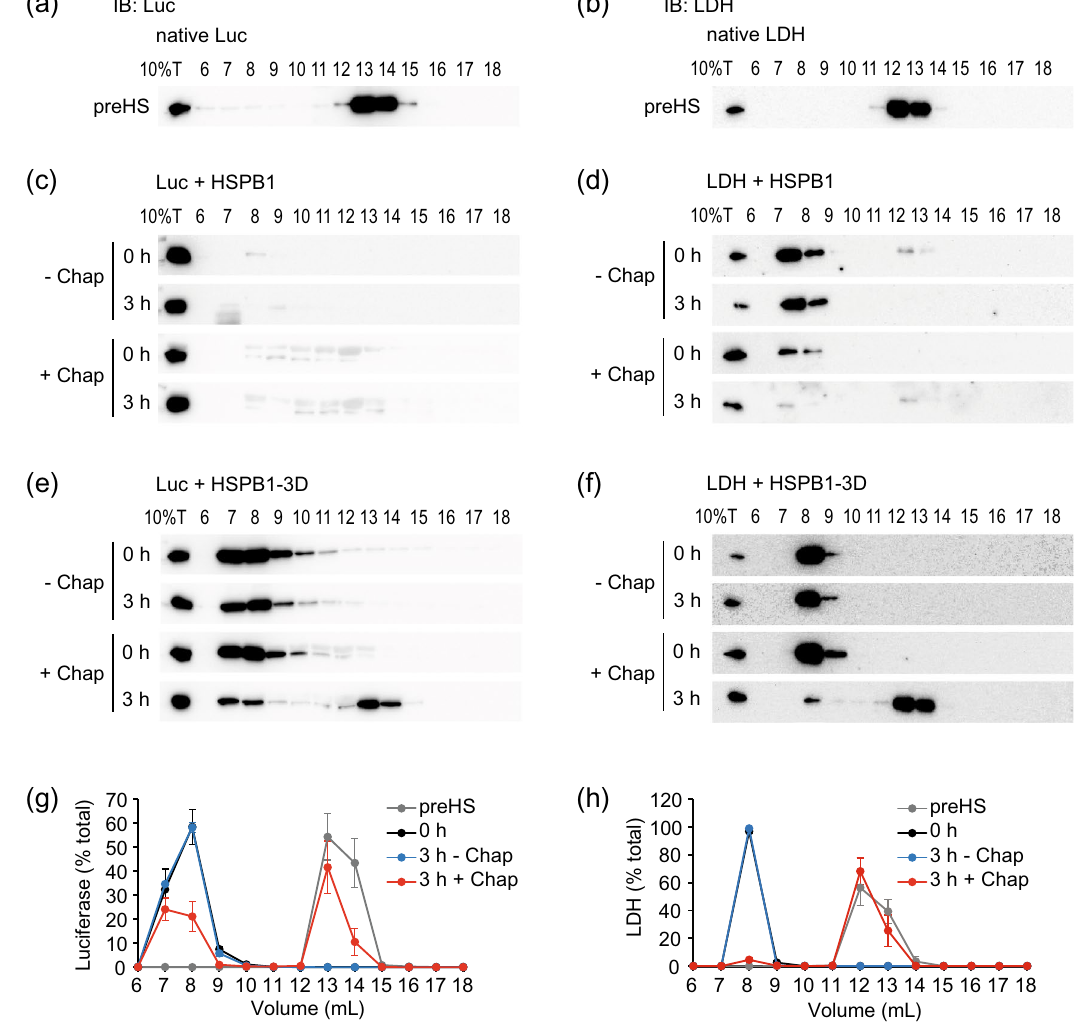
Figure 3. HSPB1-3D is required for aggregate resolubilization. ( a , b ) SEC analysis of native ( a ) luciferase and ( b ) LDH. After chromatography, the elution patterns of proteins were detected by immunoblot (IB). For comparison, 10% of total protein (10%T) before chromatography was also detected. ( c – f ) Disaggregation of aggregates composed of ( c ) luciferase and HSPB1, ( d ) LDH and HSPB1, ( e ) luciferase and HSPB1-3D, or ( f ) LDH and HSPB1-3D. The aggregates were formed at 45 ℃ or 55 ℃ for 15 min and transferred to disaggregation reactions containing buffer (− Chap) or the chaperone disaggregation machinery (+ Chap) and ATP. Aggregate resolubilization at the start (0 h) and end (3 h) of the disaggregation reactions was analyzed by SEC and immunoblot (IB). ( g , h ) Quantification of ( g ) luciferase or ( h ) LDH aggregates with HSPB1-3D from e and f in eluted fractions are shown as percentage of the total amount of immunoblot signal. Error bars show standard deviations, n ≥